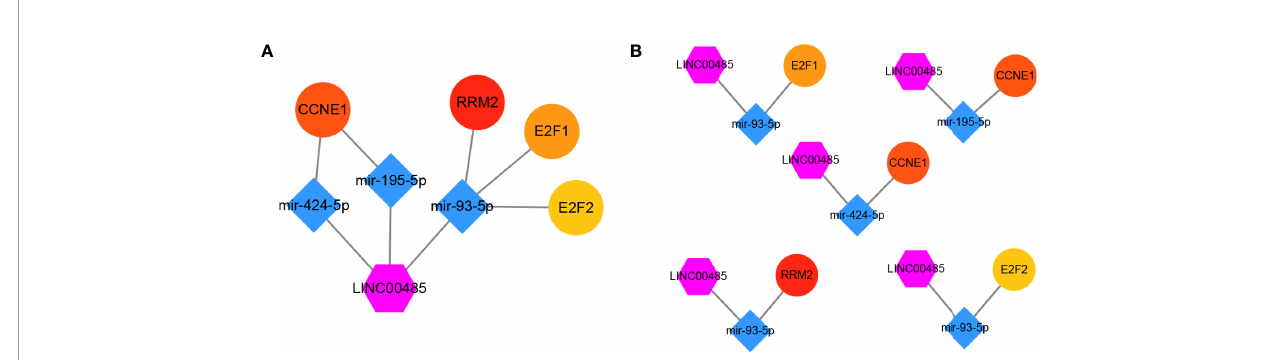
FIGURE 10 | Visualization of the main network. (A) One candidate lncRNA (purple hexagon), three candidate miRNAs (blue diamond) and four candidate mRNAs (ellipse) form the main network. (B) fi ve possible pathway axes identi fi ed from the